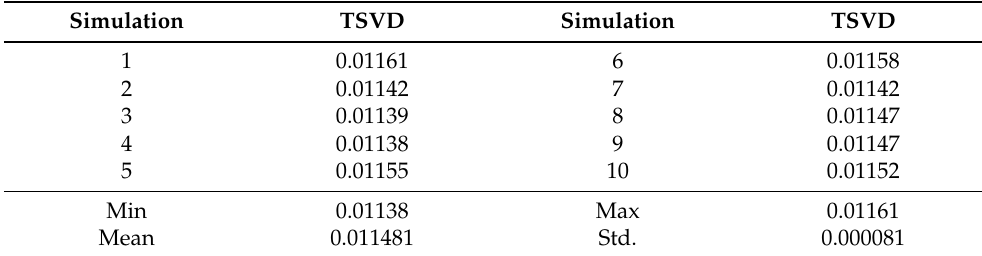
Table 4. Stochastic behaviour of SALFJA on PG and E 69 bus test system.